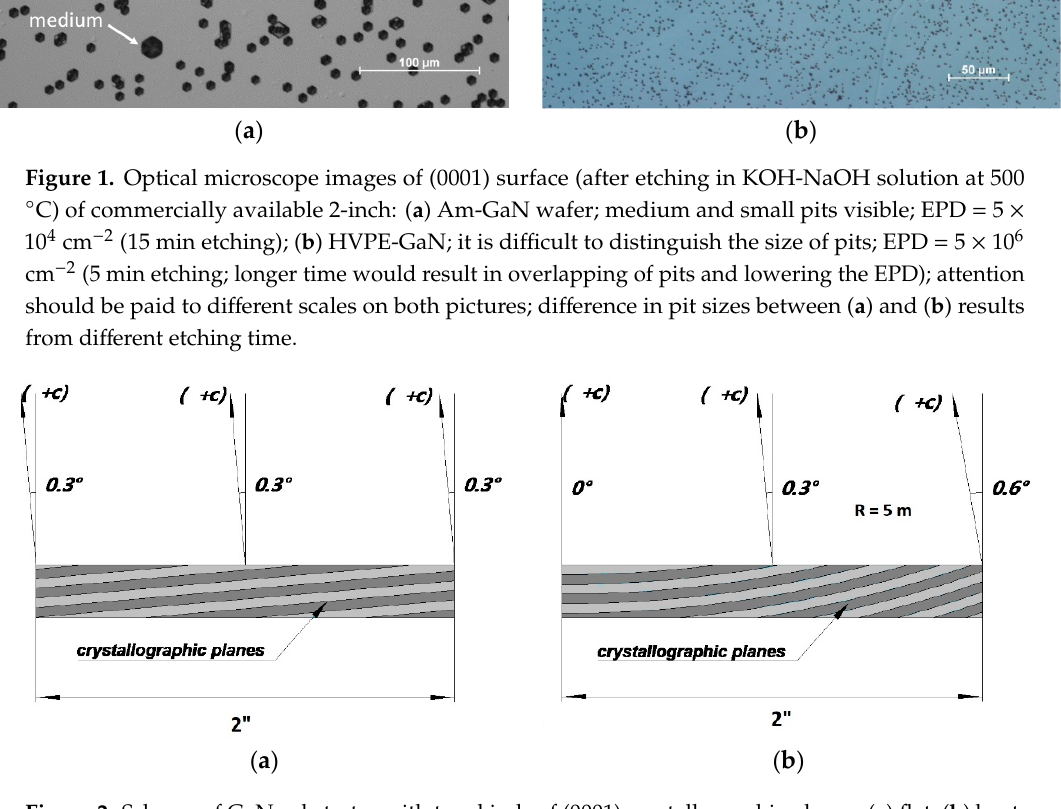
Figure 1. Optical microscope images of (0001) surface (after etching in KOH-NaOH solution at 500 °C) of commercially available 2-inch: ( a ) Am-GaN wafer; medium and small pits visible; EPD = 5 × 10 4 cm − 2 (15 min etching); ( b ) HVPE-GaN; it is difficult to distinguish the size of pits; EPD = 5 × 10 6 cm − 2 (5 min etching; longer time would result in overlapping of pits and lowering the EPD); attention should be paid to different scales on both pictures; difference in pit sizes between ( a ) and ( b ) results from different etching time.